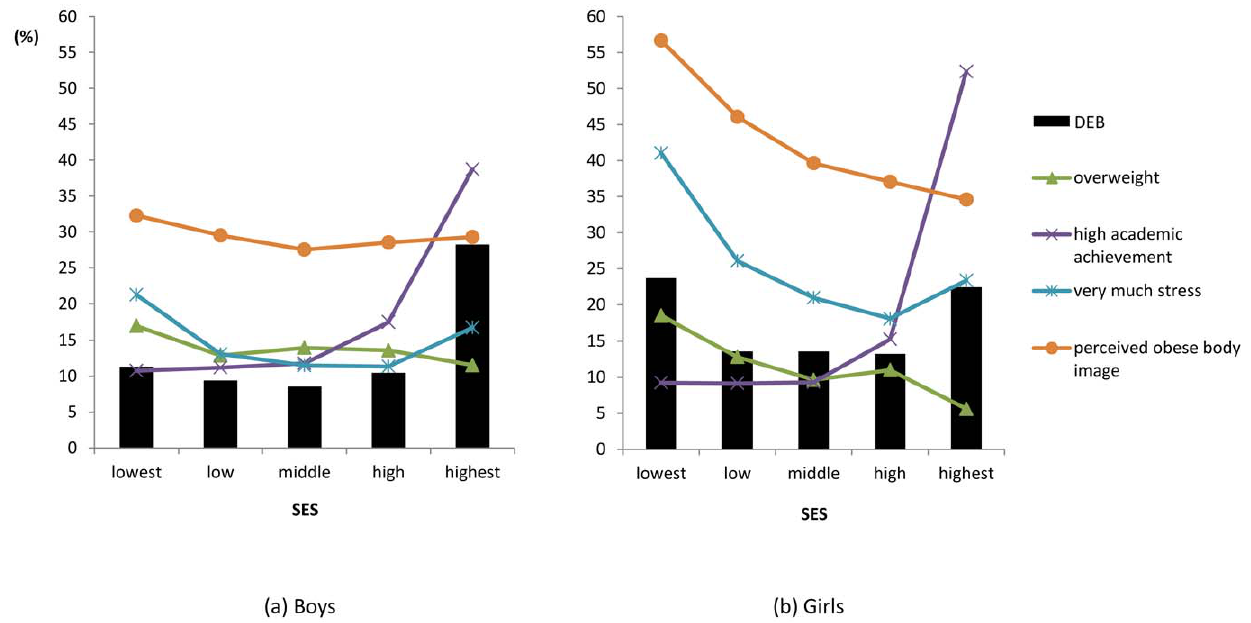
Figure 1. Distribution of Disturbed Eating Behavior (DEB) and related factors by Socioeconomic Status (SES) in boys and girls. We calculated the prevalence (%) and 95% Confidence Interval of DEB among those who were overweight, were very stressed, perceived themselves as fat, and had high academic achievement according to SES by gender.